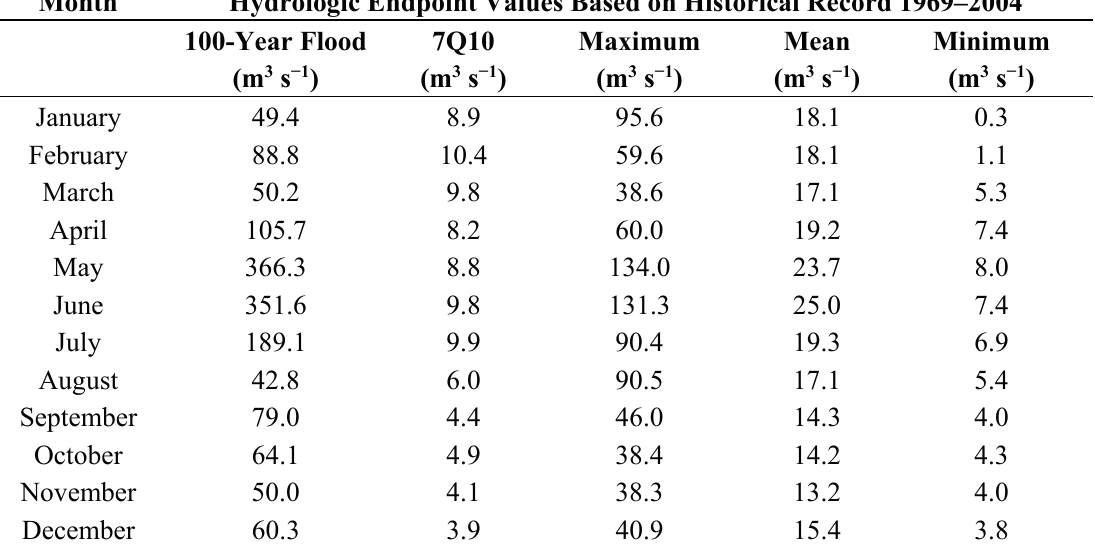
Table 1. Monthly averages for the hydrologic endpoints values based on historical records 1969–2004 ( Data Source : Weather Station OH335268 near Milford, Ohio,